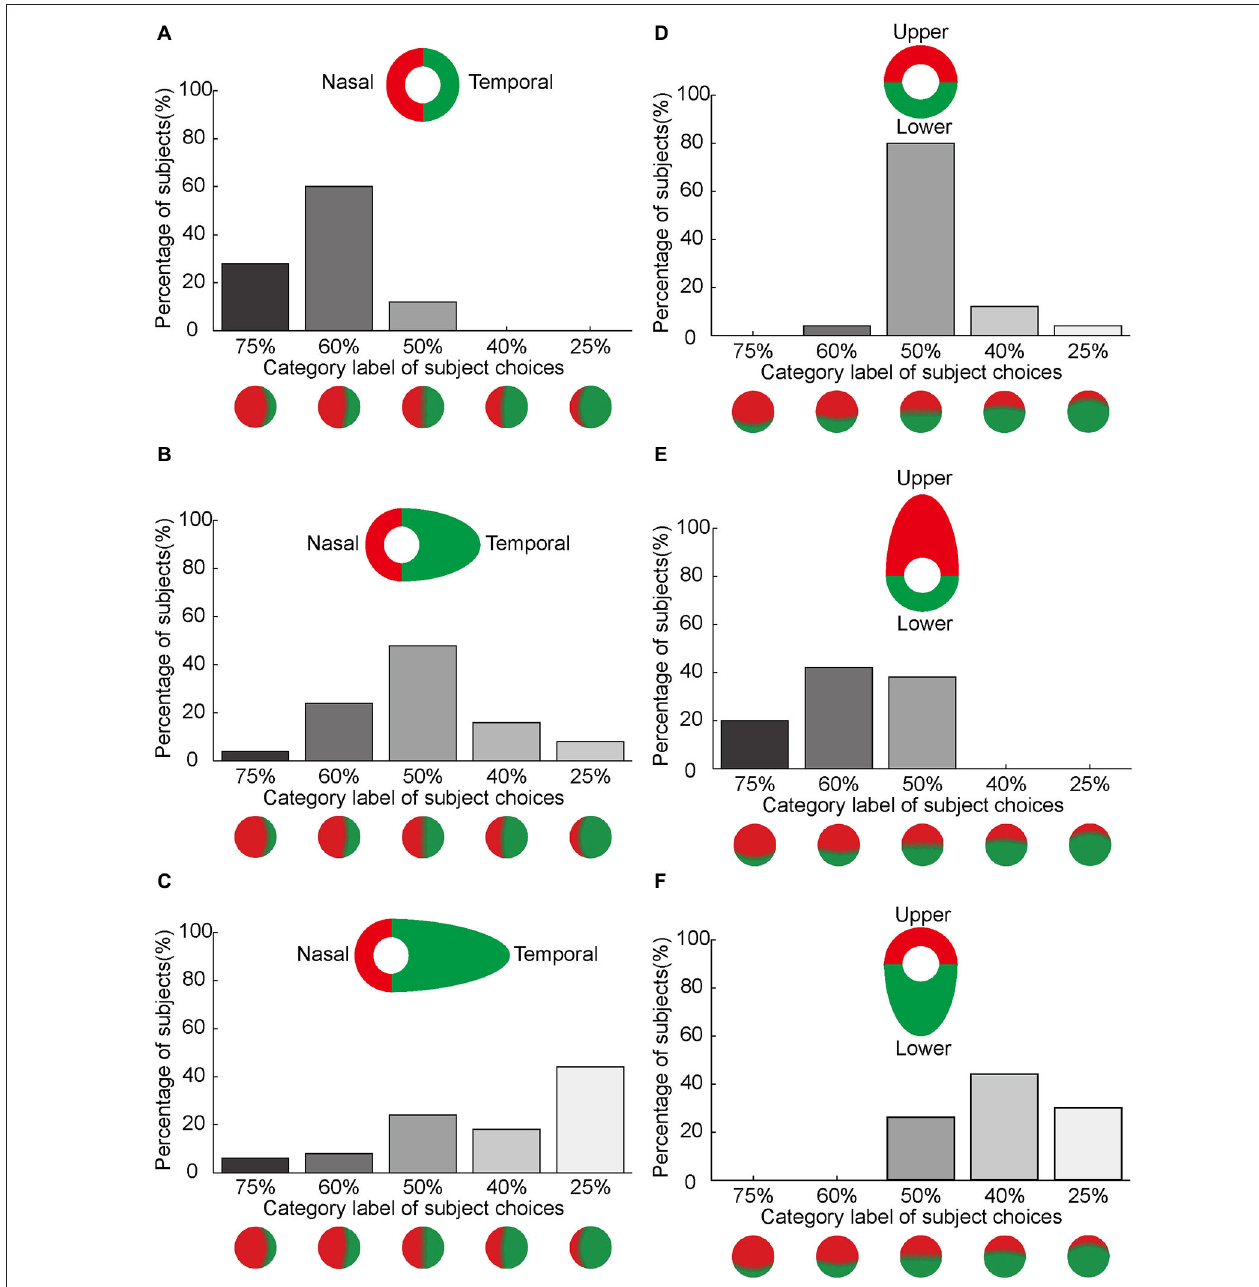
14 ◦ (C) , respectively. Notice that the nasal color dominance in (A) shifts towards equal dominance in (B) and temporal color dominance in (C) as the width of the temporal half ring increases. (D–F) illustrates the effect of increasing annulus width on the upper and lower sides of the blind spot. The width of the half ring was set to 2.5 ◦ for both sides (D) . A shift in color dominance occurs either from upper to lower (E) or from lower to upper (F) as the width